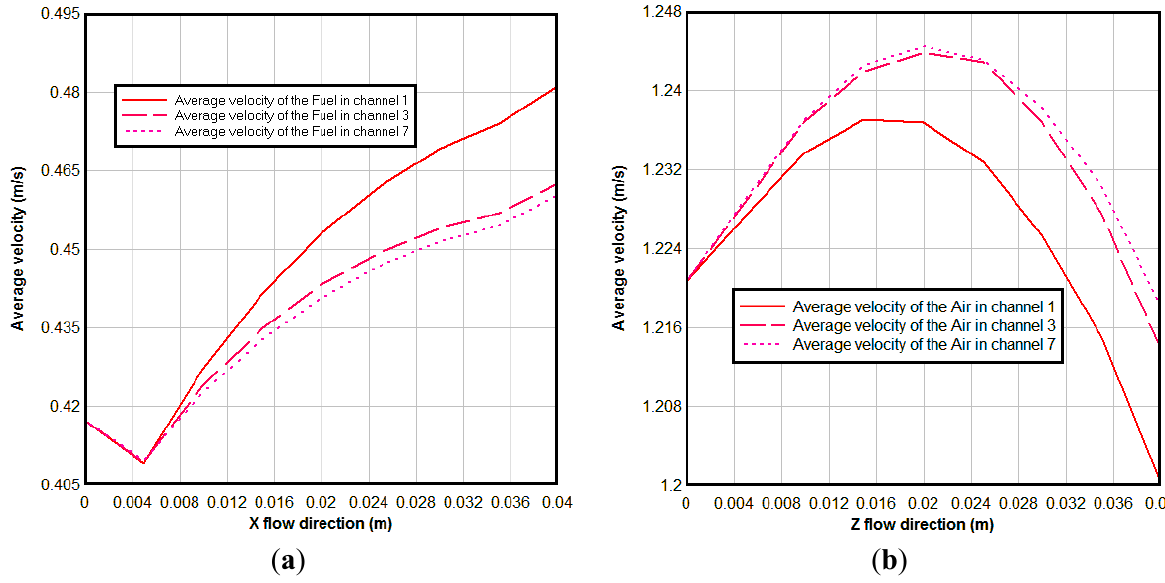
Figure 7. Average velocity of the gas in: ( a ) fuel; ( b ) air channels.